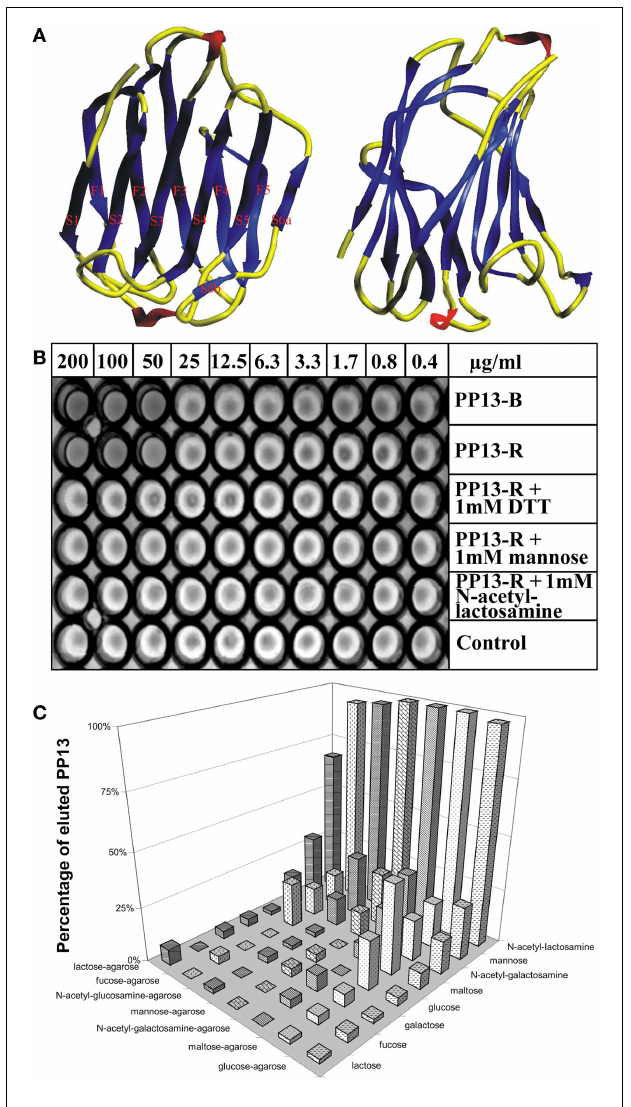
FIGURE 2 |The structural and functional basis for renaming of PP13 as galectin-13 . (A) The figure depicts the “jelly-roll” fold of PP13, which consists of five- and six-stranded β -sheets linked by two α -helices. (B) In vitro assays revealed haemagglutinating activity of placenta-purified (PP13-B) and recombinant (PP13-R) PP13. In non-reducing conditions, both PP13-B and PP13-R agglutinated human erythrocytes at ≥ 50 µ g/ml protein concentrations.The haemagglutinating ability of PP13-R was inhibited by dithiothreitol or sugars at ≥ 1mM concentrations. (C) The strength of PP13-R binding to sugar-coupled agarose beads increased from lactose-agarose to glucose-agarose (left to right). PP13 bound to sugar-coupled agarose beads was competitively eluted by sugars (1M) listed back to front. PP13 had the best eluting capacity (sugar affinity) for N -acetyl-lactosamine, mannose and N -acetyl-galactosamine. Figure (A) was published in Ref. (11), and Figures (B,C) in Ref. (9). Kind permission for the reuse of figures was obtained from Oxford University Press (A) and JohnWiley and Sons (B,C) .